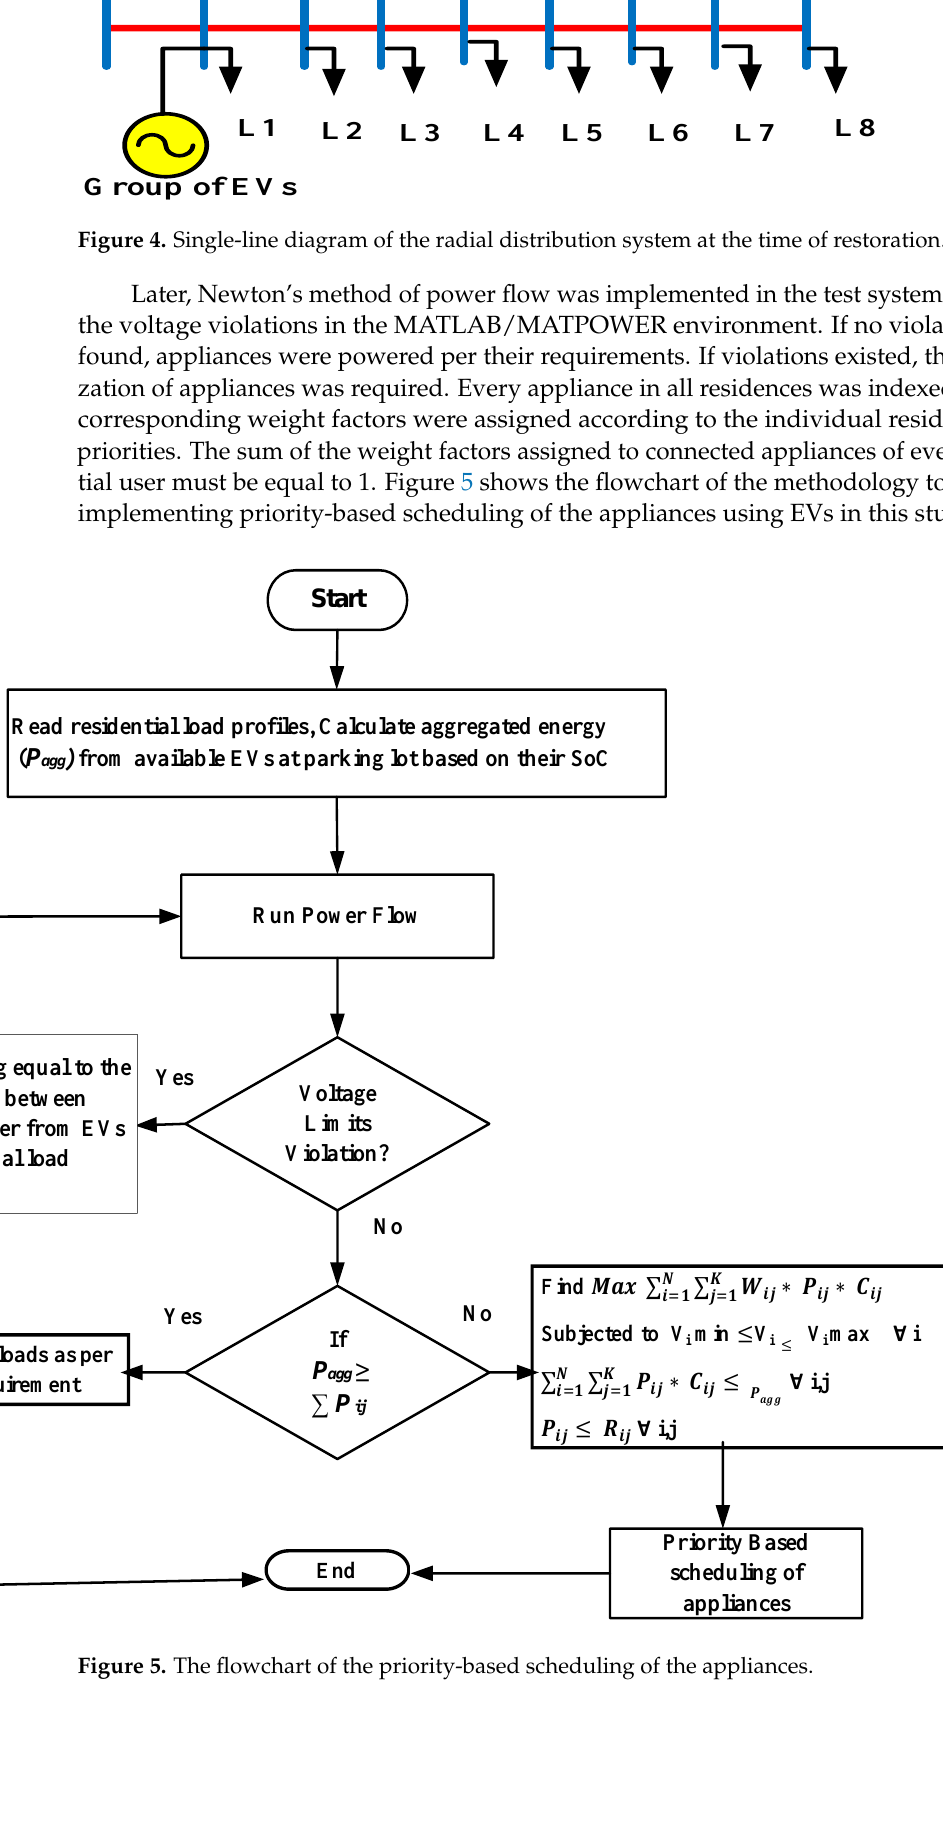
8 of 17 Figure 3. Single-line diagram of the radial distribution system under consideration At the time of the blackout, for the service restoration, the EVs ’total energy was ag-